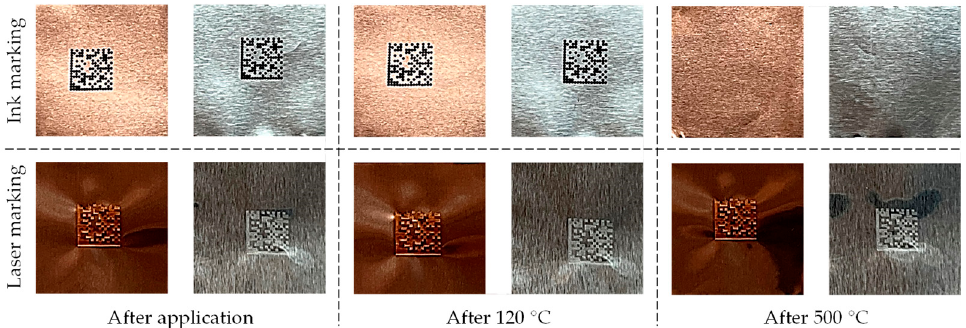
Figure 8. Lasered and printed markings/DMCs on copper and aluminum foil: left, directly after application; middle, after 120 °C electrode coil drying; right, after 2 min at 500 °C.